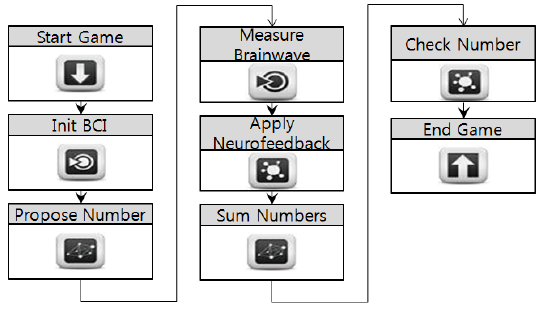
Figure 8. Expert Template for the Number Game. The flowchart contains the information of handling brainwaves and basic game processes.